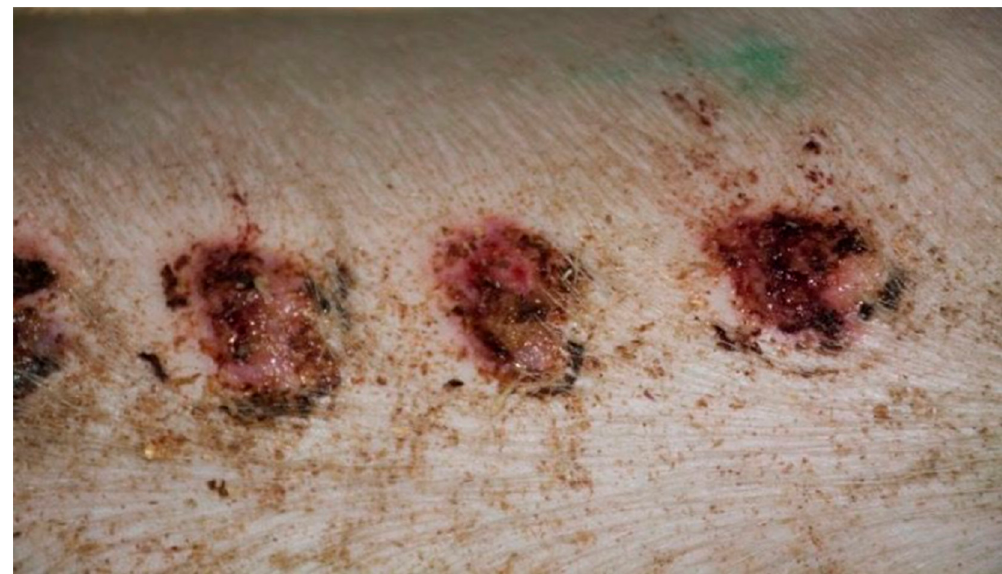
Figure 5. Group D1—burn wound treated with the 1% propolis ointment on day 15.